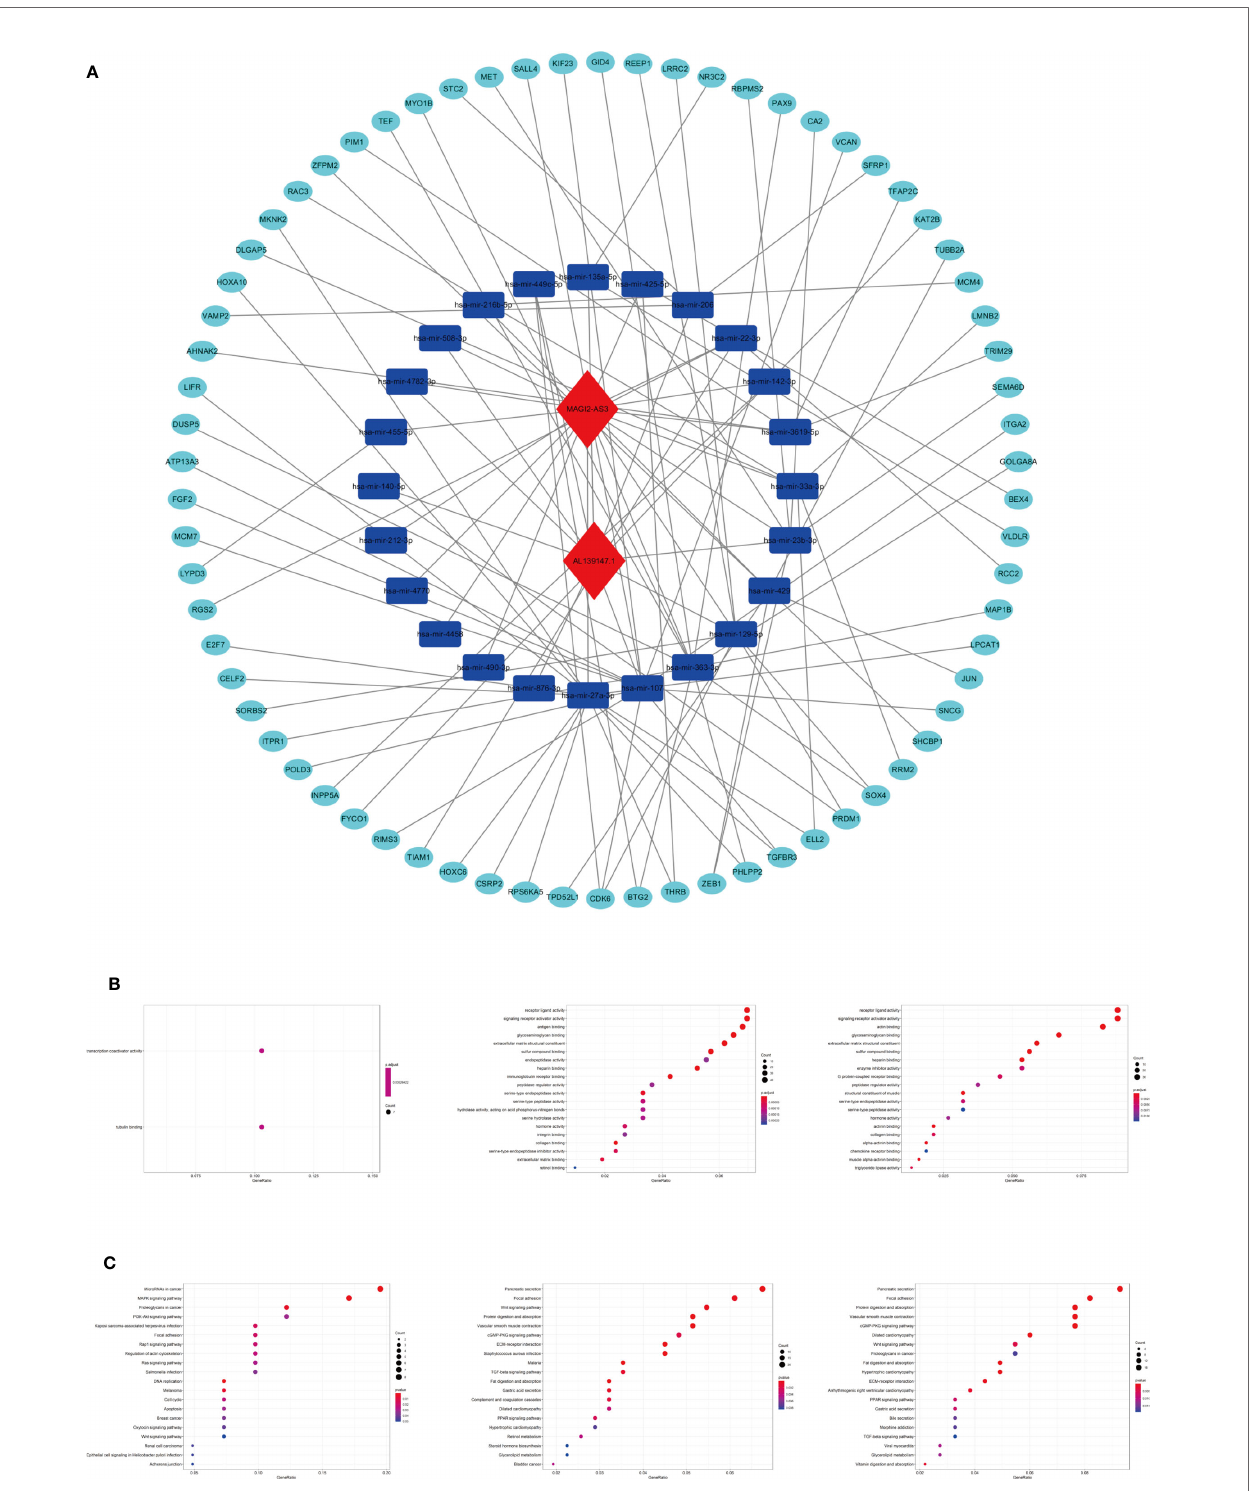
FIGURE 11 | The ceRNA network construction and biological function analysis. (A) The ceRNA network of two lncRNAs (red) and their target miRNAs (blue) and mRNAs (green). (B) GO analysis in 70 target mRNAs, differentially expressed genes between cluster I and cluster II, differentially expressed genes between the high- riska and the low-risk group. (C) KEGG pathway analysis in 70 target mRNAs, differentially expressed genes between cluster I and cluster II, differentially expressed genes between the high-risk group and the low-risk